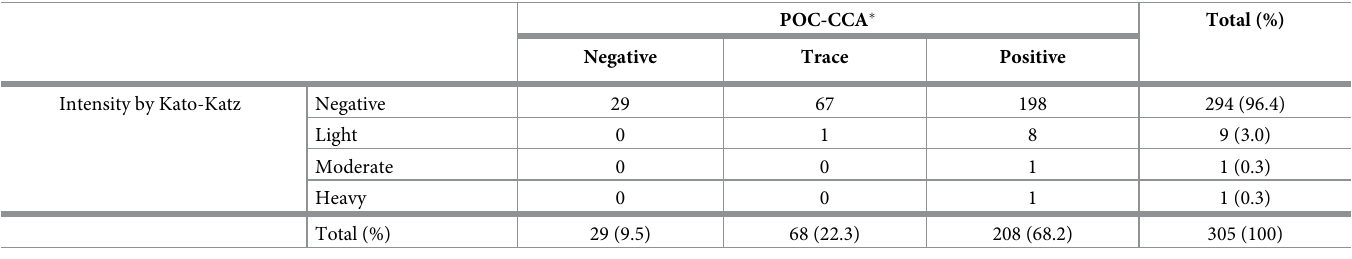
Table 3. Intensity of S . mansoni infection by Kato-Katz by POC-CCA